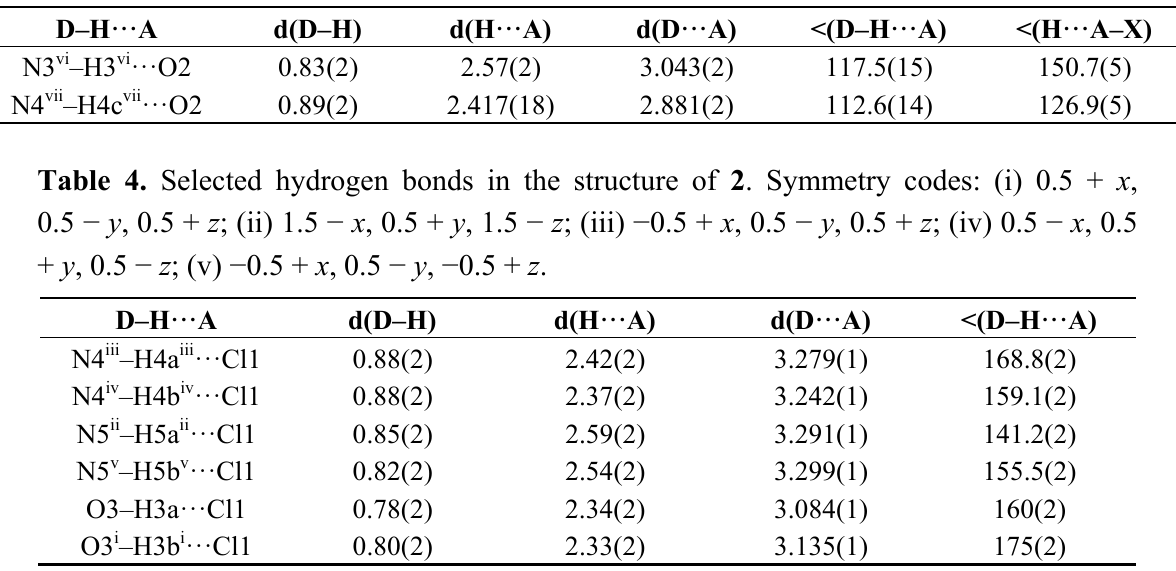
Table 3. Selected hydrogen bonds in the structure of 2 . Symmetry codes: (vi) 1.5 − x ,